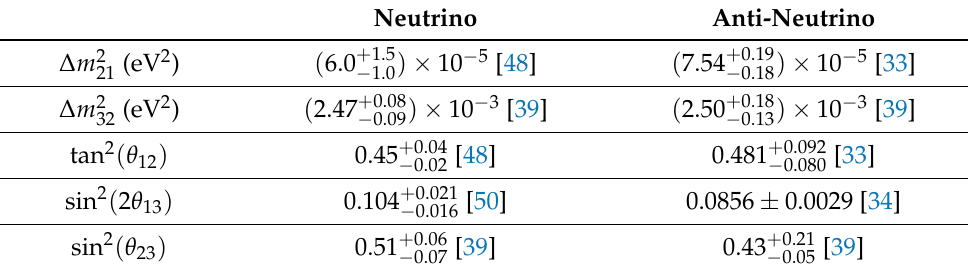
Table 1. Neutrino and antineutrino mass squared differences and mixing